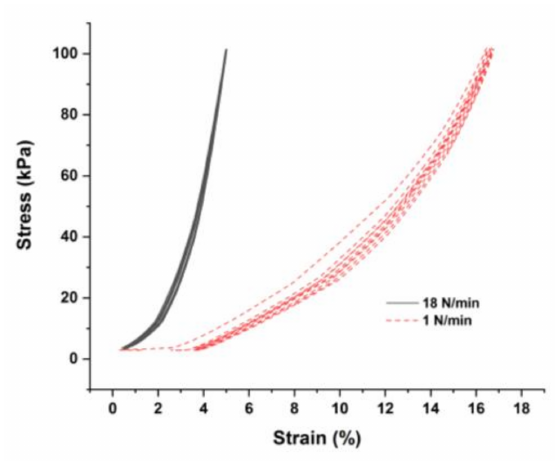
Figure 8. Stress–strain diagrams of 3D-printed PLA/1 wt.% MWNT with different force rates in a cyclic